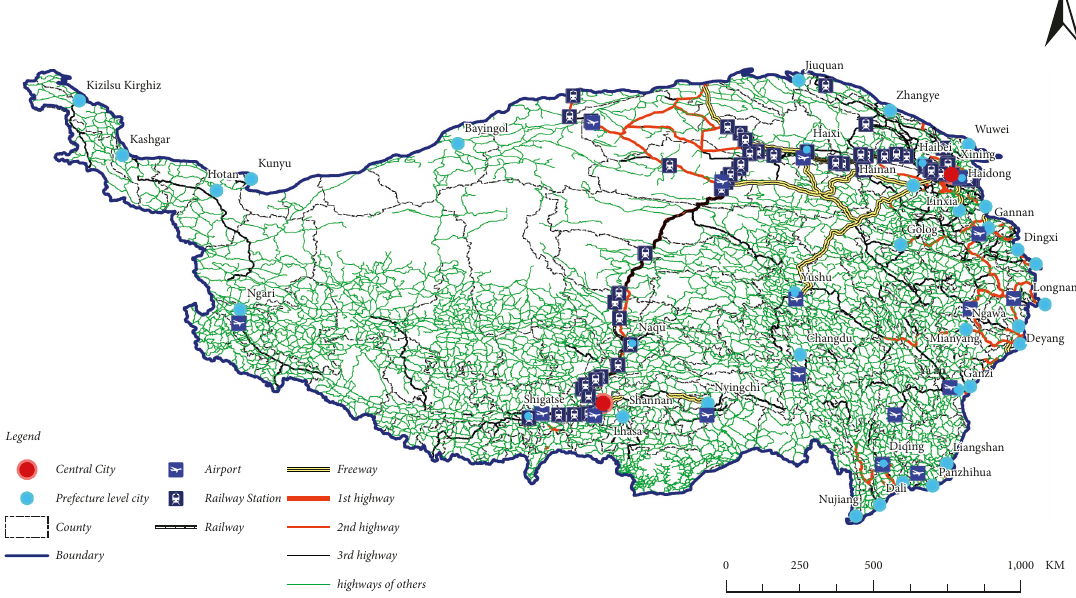
Figure 5: Spatial distribution of transportation datasets.